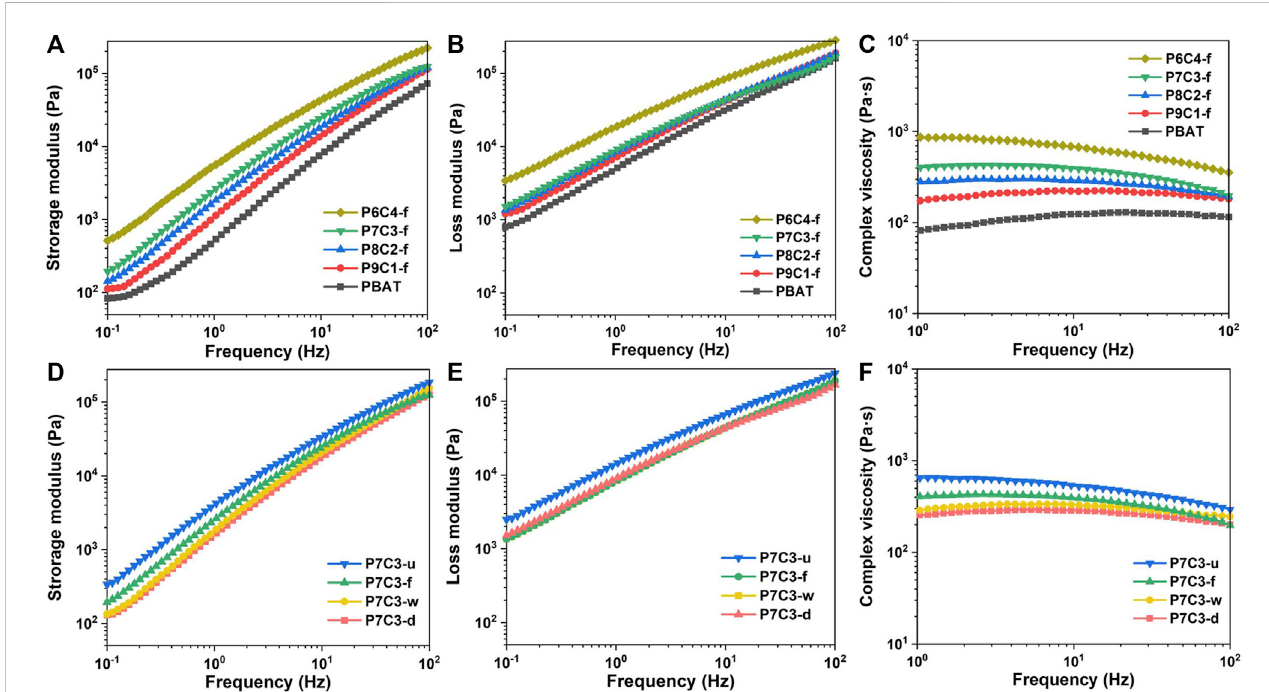
FIGURE 4 (A) Storage modulus, (B) loss modulus, and (C) complex viscosities of PBAT composites fi lled with different content of gas – solid fl uidization modi fi ed